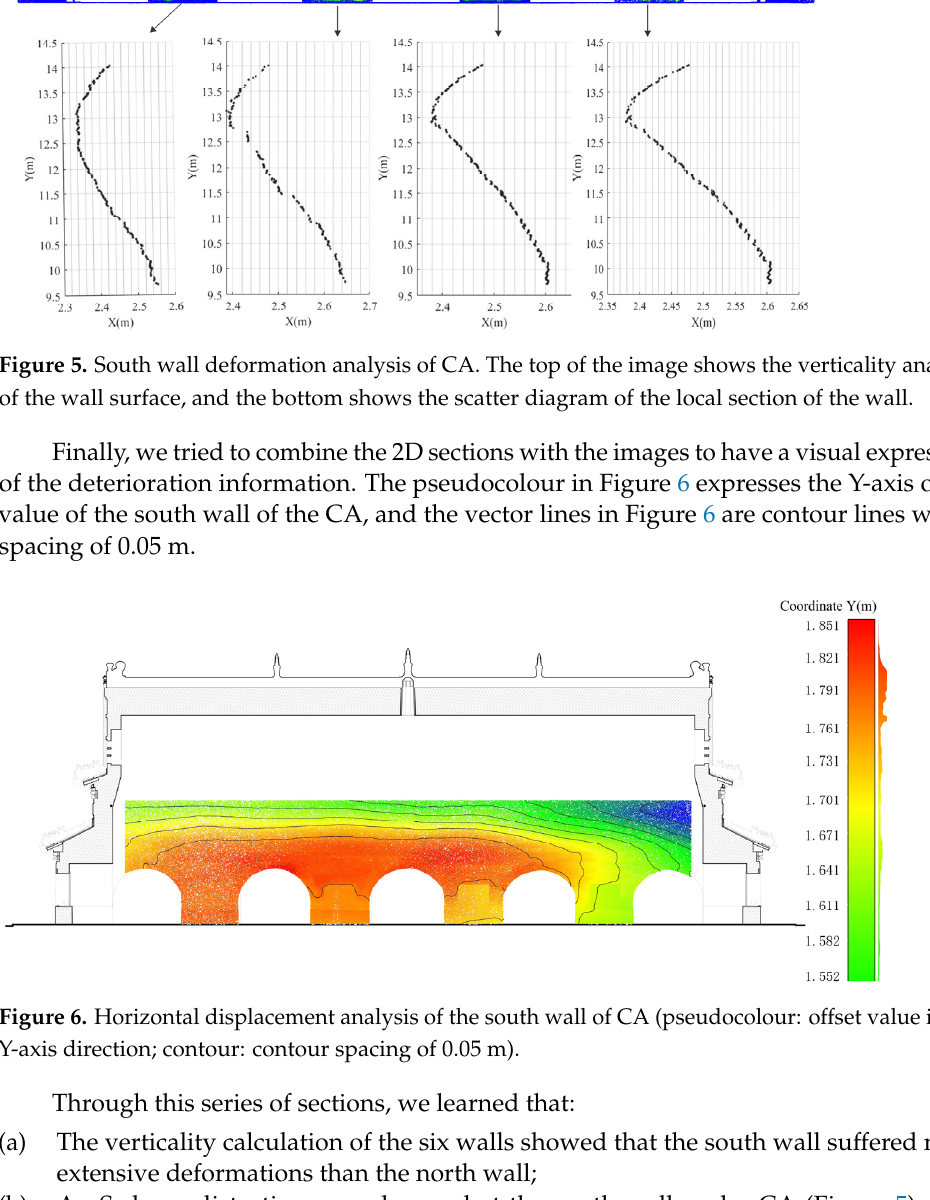
Figure 6. Horizontal displacement analysis of the south wall of CA (pseudocolour: offset value in the Y-axis direction; contour: contour spacing of 0.05 m).